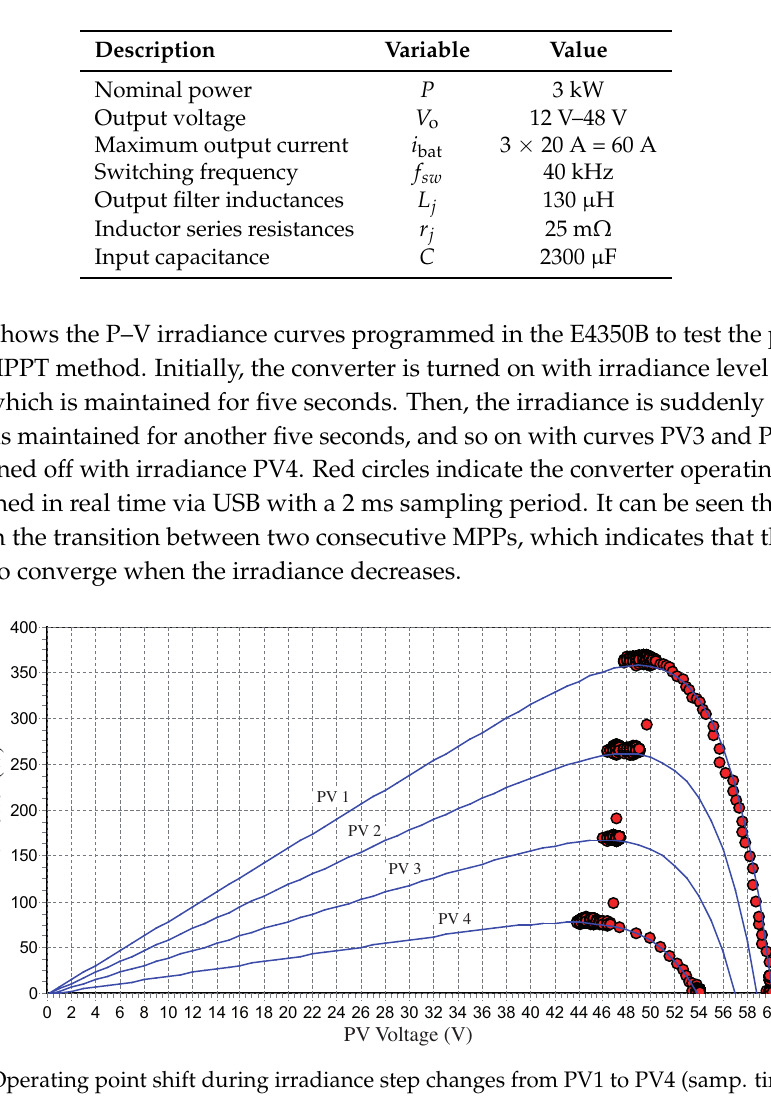
Table 2. Power converter parameters.